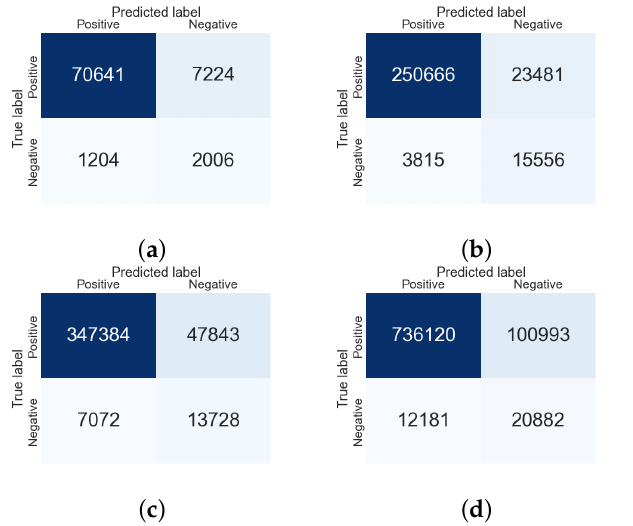
Figure 4. Confusion matrices for the evaluation percentages presented in Table 5, namely TP, TN, FP, FN rates, for PeX’s execution per technique and subset. ( a ) Normal Subset; ( b ) NormalVsMalicious01 Subset; ( c ) NormalVsMalicious02 Subset; ( d ) FullSet Subset.